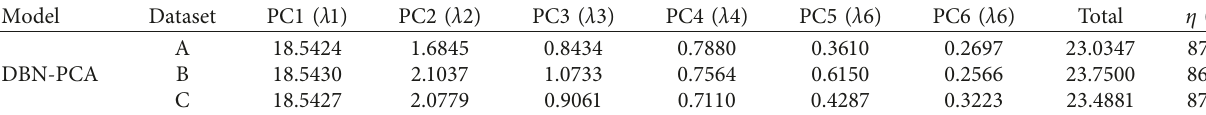
Table 3: The results of PC1-PC2 and the value of η